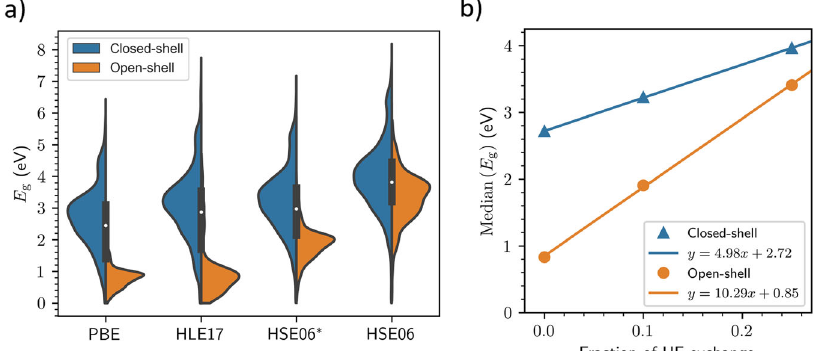
Fig. 2 Difference in band gap distributions for materials with closed- and open-shell character. a Violin plots of the predicted band gaps, E g , for 10,720 structures in the QMOF Database calculated with PBE, HLE17, HSE06 * , and HSE06. The left and right sides of each violin plot include structures with closed-shell (8628 structures) and open-shell (2092 structures) character, respectively. A box plot is included inside each violin, highlighting the extrema (whisker edges), interquartile range (box boundaries), and median (white dot) of the band gap data at the speci fi ed level of theory. b Median band gap as a function of the fraction of Hartree – Fock (HF) exchange at small interelectronic separation where 0% = PBE, 10% = HSE06 * , and 25% = HSE06. The blue triangles and orange circles are the median band gaps for the closed- shell and open-shell structures, respectively. The solid lines display the linear best- fi t